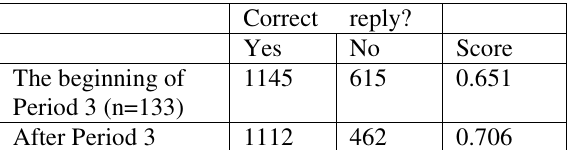
Table 1. The 2x2 table summarizing counts from the 2015 course of how often students replied correctly to the syllogisms in the beginning of Period 3 and immediately after this period. These values may be compared with the value (from earlier studies) of the score before the teaching starts, i.e. 0.608.